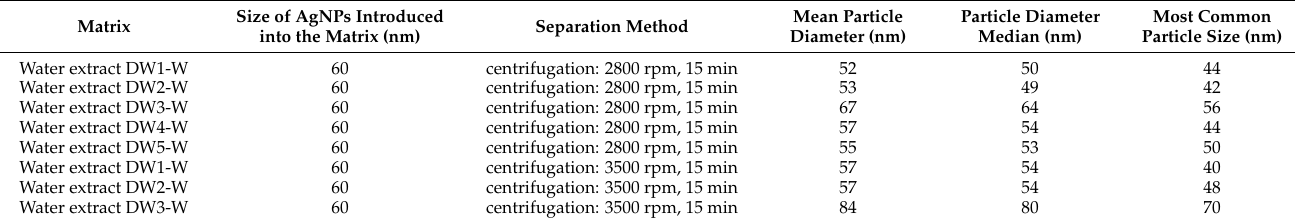
Table 4. Verification of the effect of centrifugation velocity for a centrifugation time of 15 min on nanoparticle separation efficiency for water extract samples DW(1  5)-W of drilling waste enriched with AgNPs (60 nm). Matrix Size of AgNPs Introduced into the Matrix (nm)